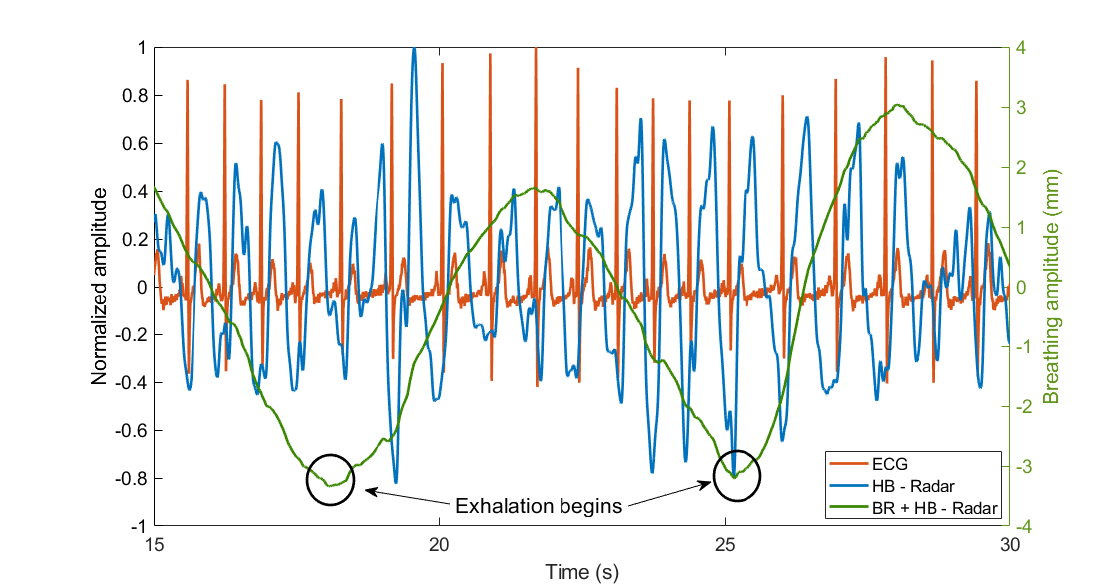
Figure 13. Heartbeat waveform extracted from a breathing subject compared with its reference ECG. It also shows the relative displacement acquired with the radar, which contains the breathing and heartbeat signals. The subject has a respiratory rate between 8–9 breaths/min and a heart rate between 77–78